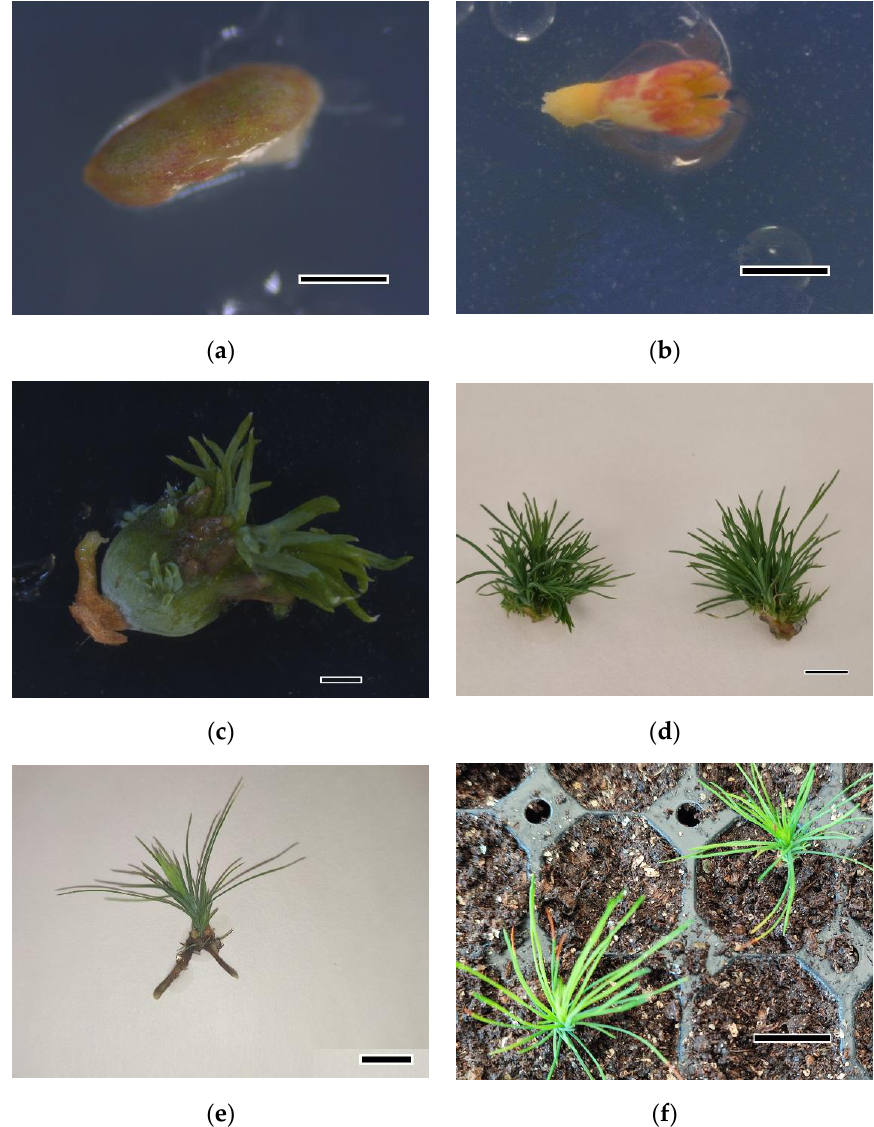
Figure 7. Plant material at different stages of Pinus ponderosa organogenic process: ( a ) cotyledon cultured for 2 weeks in LP supplemented with 22 µM 6 -benzyladenine (BA), bar = 1.5 mm; ( b ) whole zygotic embryo cultured for 1 week in LP supplemented with 22 µM BA, bar = 1.5 mm; ( c ) developing shoots from zygotic embryo cultured for 4 weeks in half LP macronutrients supplemented with 13.1 µM BA and exposed to red LEDs, bar = 3.0 mm; ( d ) shoots after 6 weeks in elongation medium, which consisted of hormone-free LP supplemented with 2 gL −1 activated charcoal, bar = 5.0 mm; ( e ) rooted shoots after 2 weeks in root induction medium, which consisted of half LP macronutrients supplemented with a mixture of 5 µM 1-naphthaleneacetic acid (NAA) and 5 µM indole-3-butyric acid (IBA), bar = 5.0 mm; ( f ) acclimatized shoots exposed to fluorescent light in in vitro conditions after 4 weeks in ex vitro conditions in the greenhouse, bar = 20 mm .